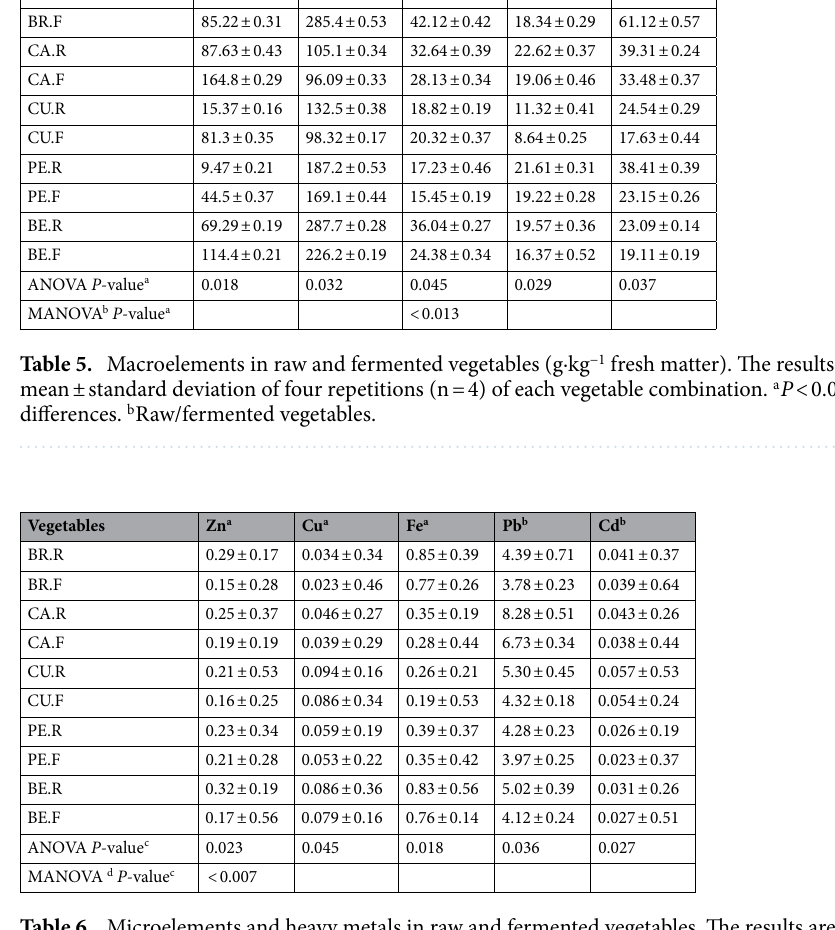
Table 6. Microelements and heavy metals in raw and fermented vegetables. The results are the mean ± standard deviation of four repetitions (n = 4) of each vegetable combination. a mg·100 g −1 fresh matter. b µg g −1 fresh matter. c P < 0.05 statistical differences. d Raw/fermented vegetables.